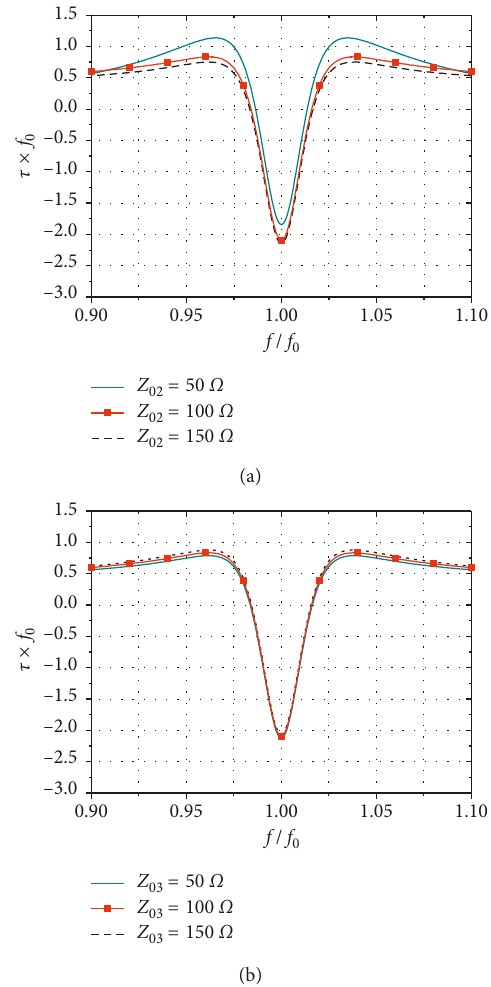
Figure 5: Effect of Z power divider: (a) Z 02 . (b) Z 03